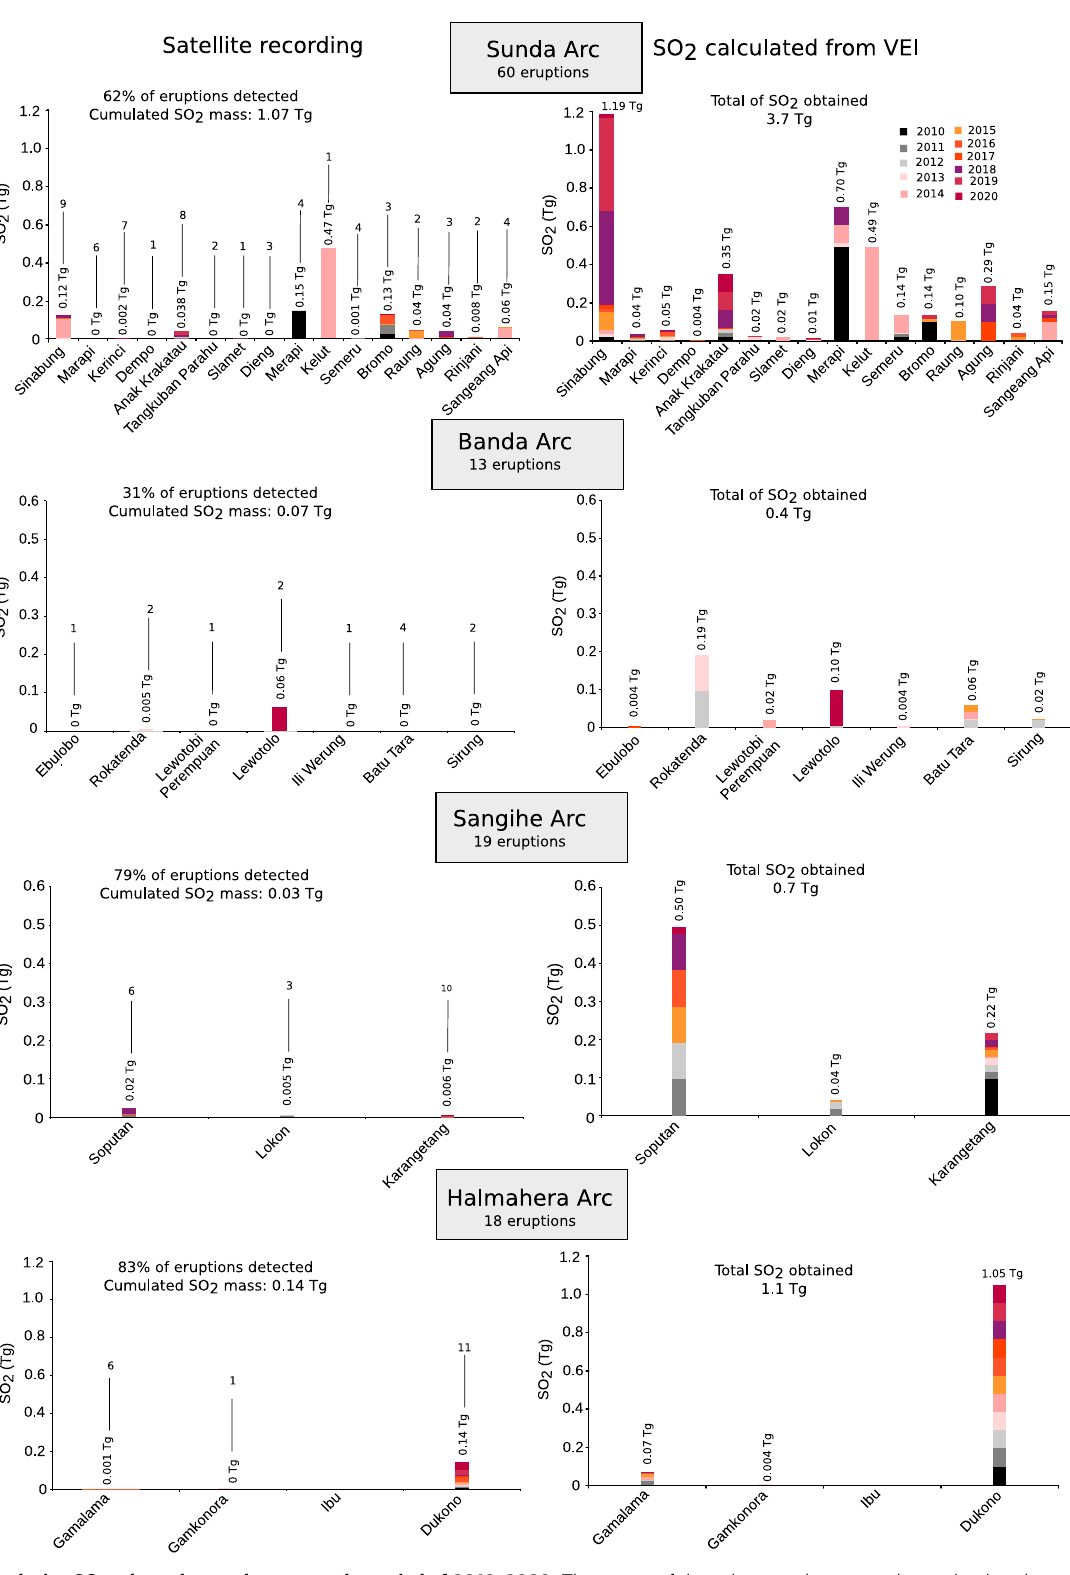
10 NATURE COMMUNICATIONS| (2022) 13:3366